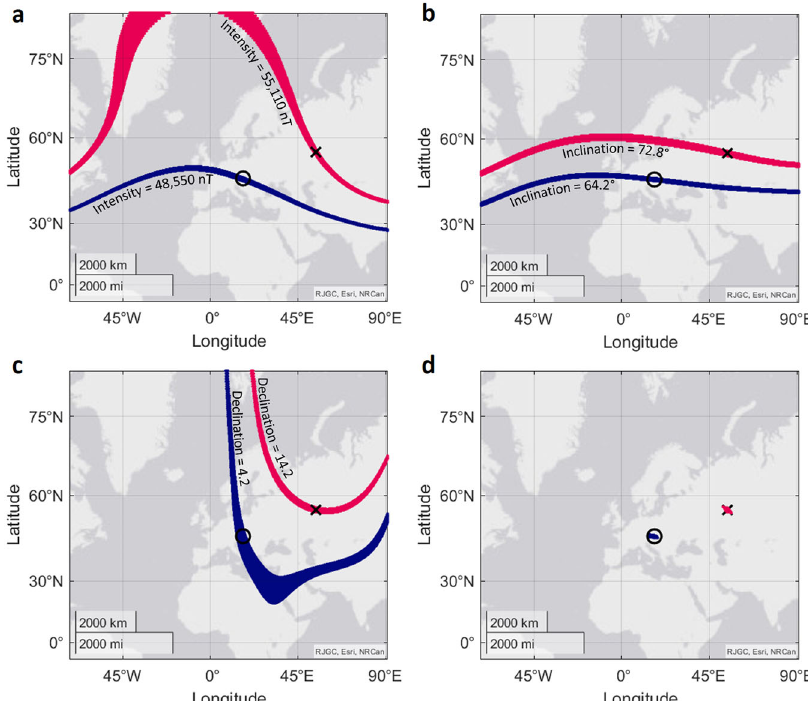
Fig. 2 Possible locations with the same values of total intensity, inclination, declination, and all three parameters combined, as found at the natural site in ref. 14 . a Locations matching the values (±200 nT) of total intensity found at the natural site (black cross, blue area), and the virtual magnetic displacement (black cross, pink area). b Locations matching the values (±0.5°) of inclination found at the natural site (black circle, blue area), and the virtual magnetic displacement (black cross, pink area). c Locations matching the values (±0.5°) of declination found at the natural site (black circle, blue area), and the virtual magnetic displacement (black cross, pink area). d Possible locations for the natural site (black circle, blue area) and the virtual magnetic displacement (black cross, pink area), when all three magnetic parameters are similar pattern for both the natural fi eld value and the virtual magnetic displacement value (Fig. 2c). The different gradients of change of these three parameters makes their usefulness as part of a map dependent upon the context in which they are required.